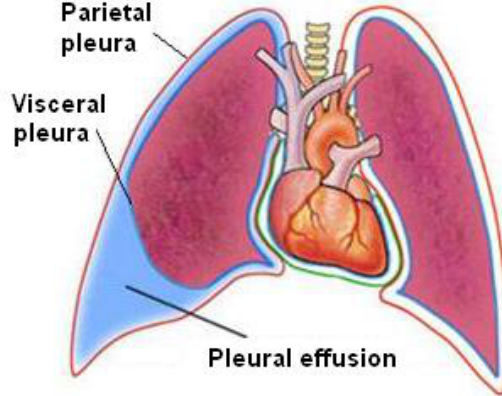
Fig. 1. Illustration showing the pleurae and the pleural effusion [13].